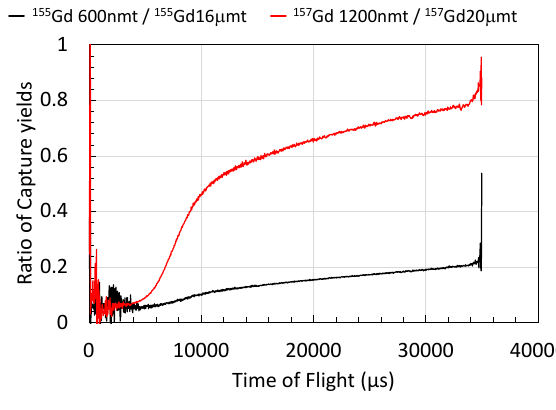
Figure 2. Ratios of capture yields for the 155 Gd and 157 Gd sam-